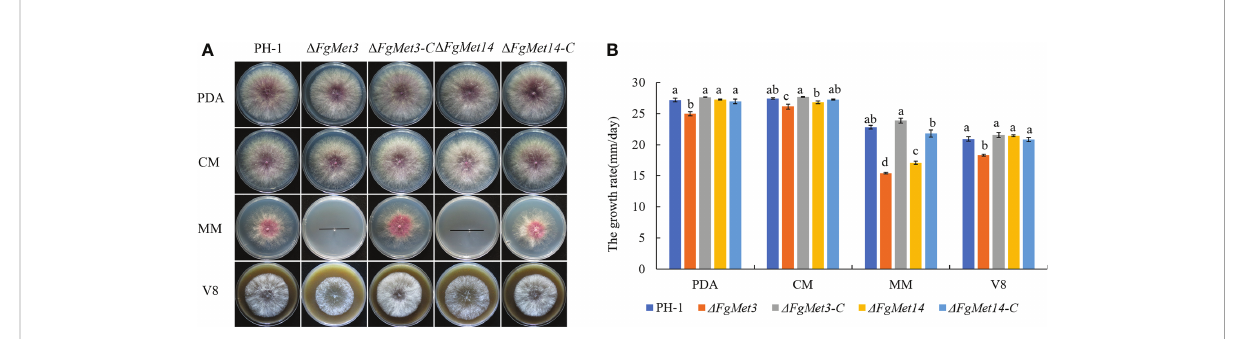
FIGURE 2 Vegetative growth of PH-1, D FgMet3 , and D FgMet14 mutants and their complements on different mediums. (A) The colonial morphology of strains on PDA, CM, MM, V8 medium at 25°C for 3 days. (B) Hyphal growth rate of the strains on PDA, CM, MM, V8 medium. Error bars in each column denote standard error of three repetitions. Within each treatment, bars with the same letter indicate no signi fi cant difference according to the least signi fi cant difference (LSD) test at p = 0.05.